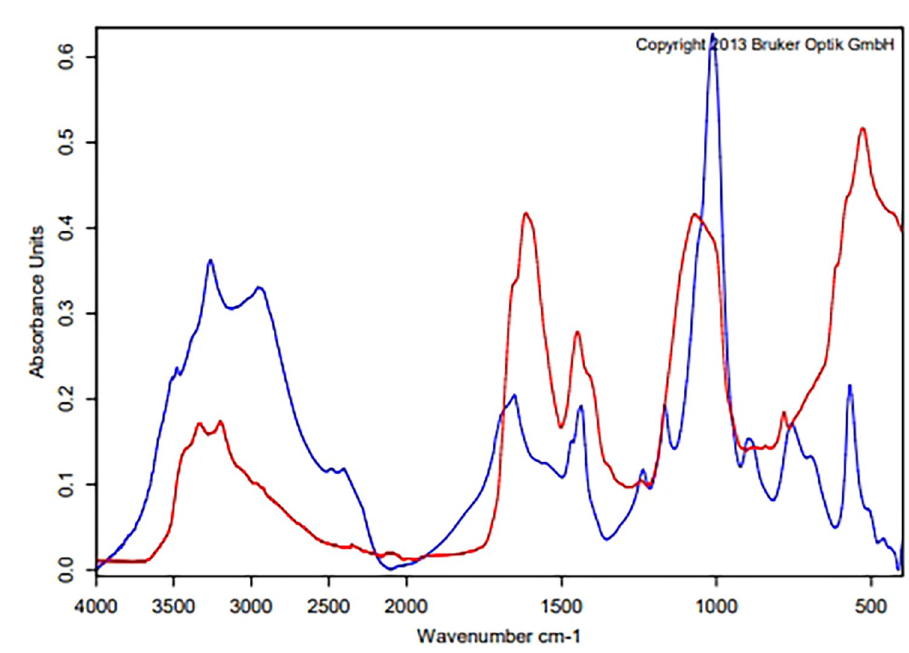
Fig 2. Search for FTIR spectrum result of crystals induced by SPMAP09 (red curve) with Bruker kidney stone library (blue curve). The main component of the crystal was identified as struvite.